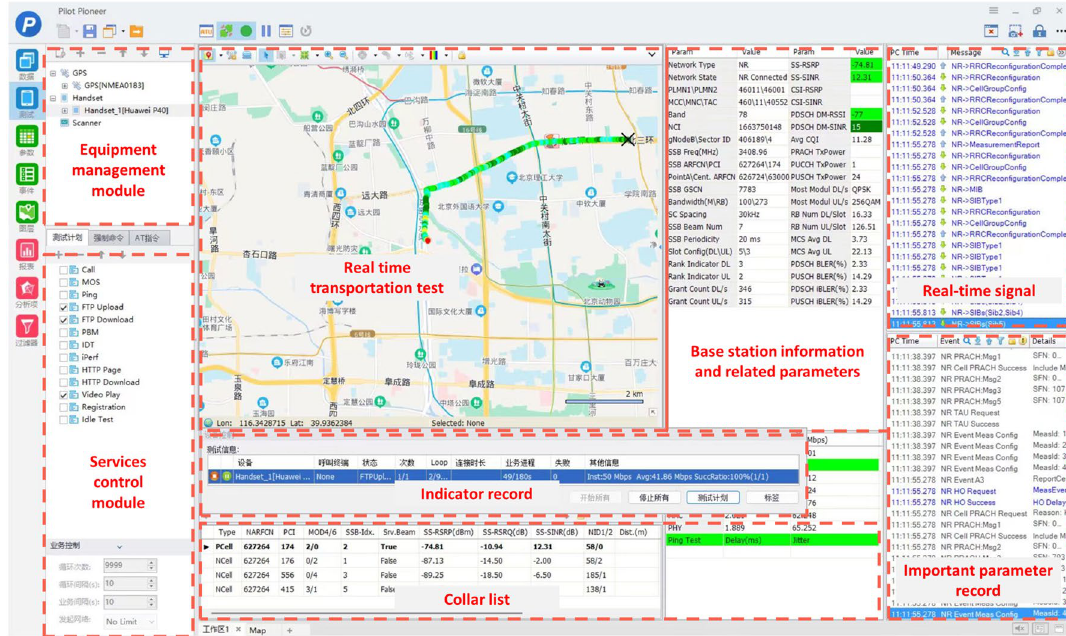
Figure 8. The pioneer software’s interface